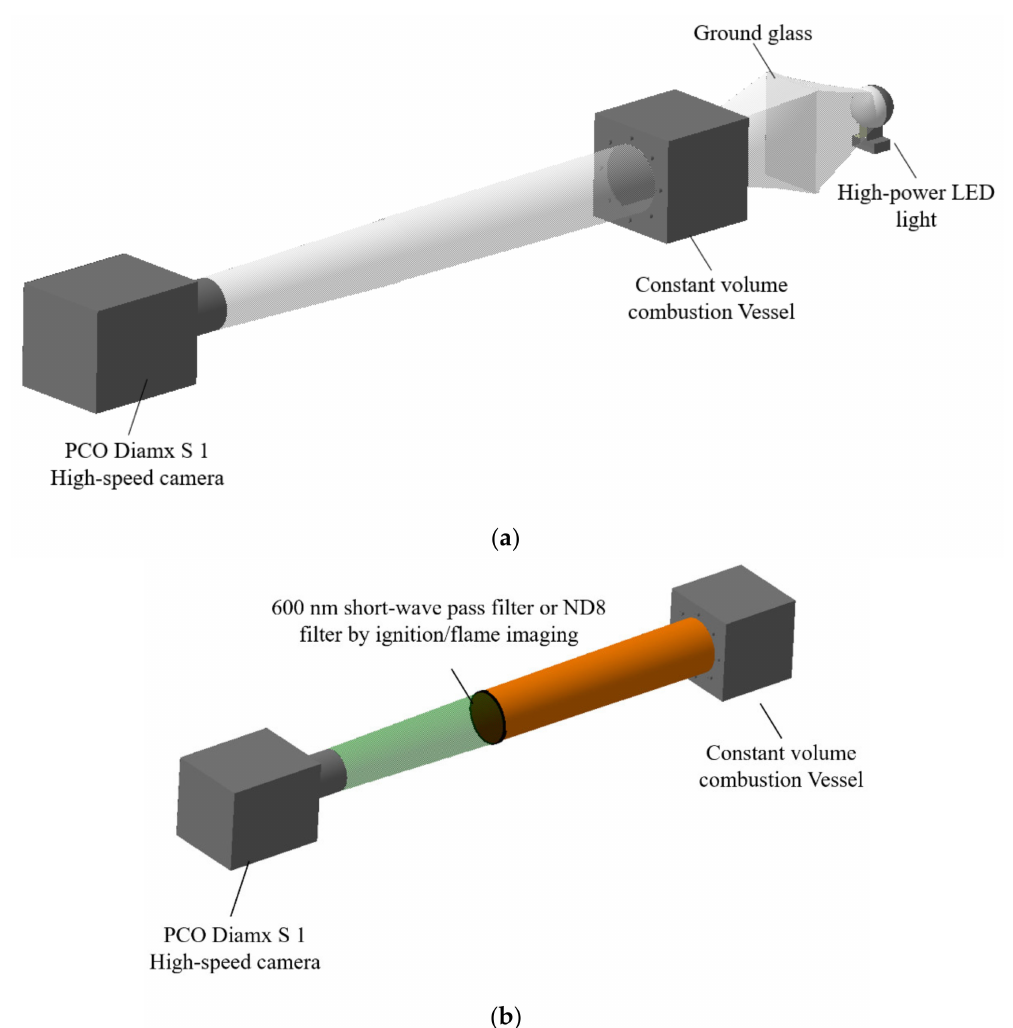
Figure 3. Sketch map of the imaging methods, ( a ) LED backlight scattering imaging, ( b ) wide area low-pass chemiluminescence imaging and reduced light direct